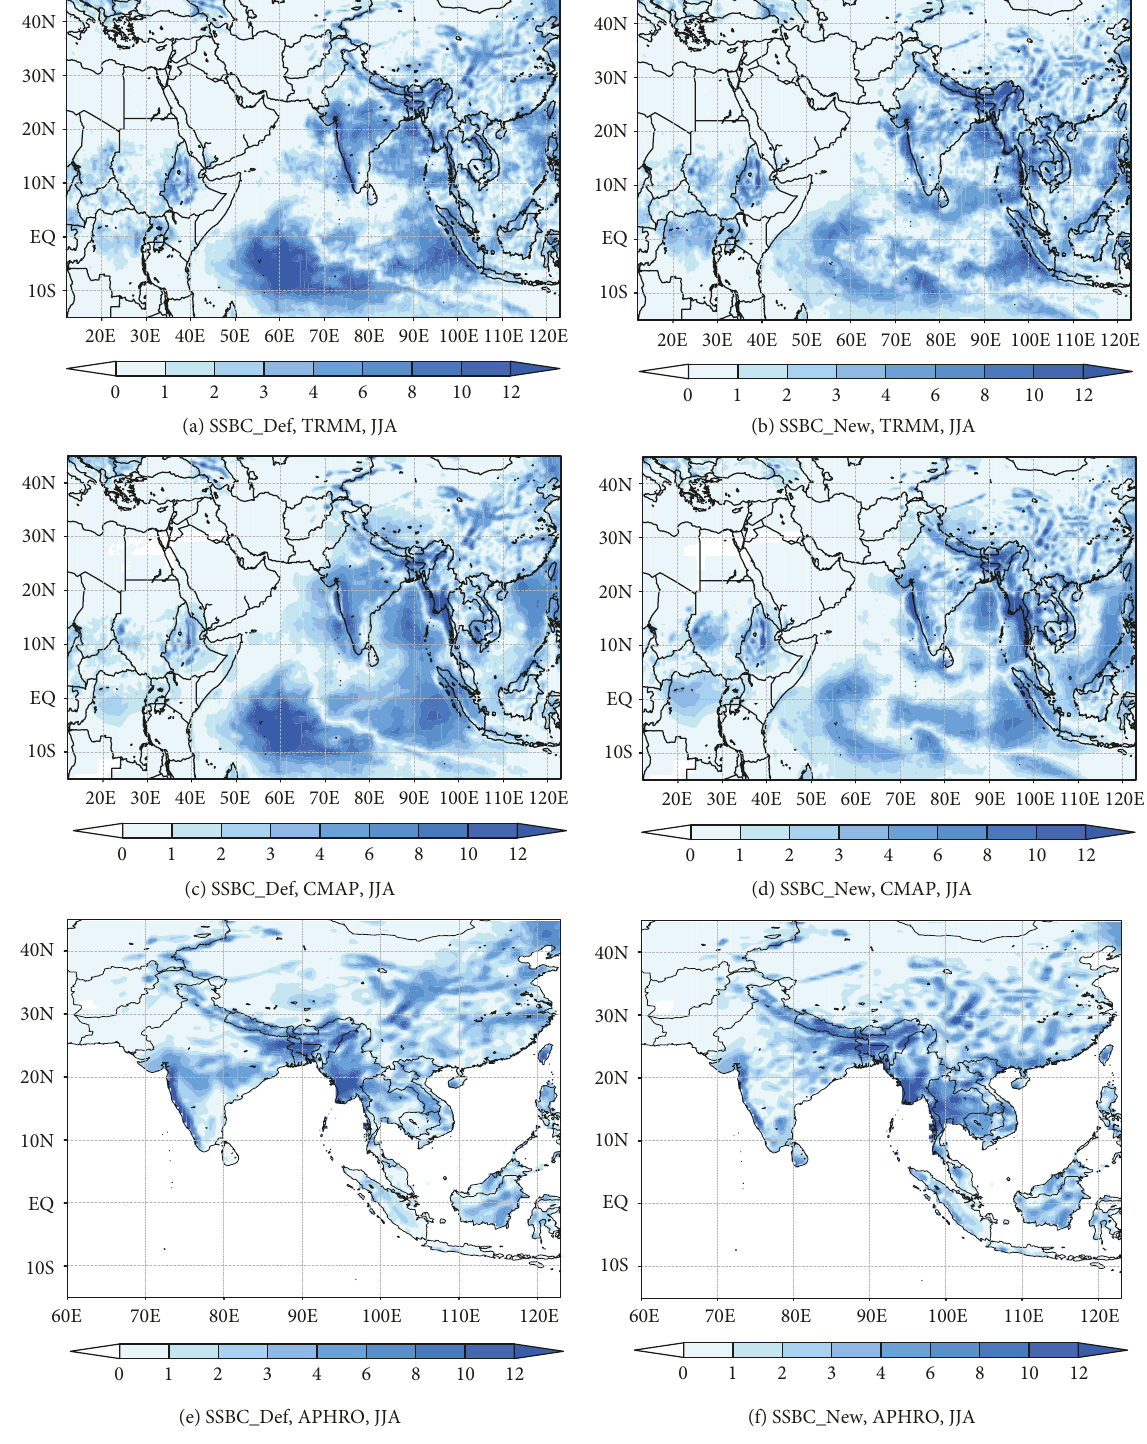
Figure 3: Root-mean-square error (RMSE) comparison of surface precipitation for June-July-August (JJA), 2005, of SSBC_Def (left column) and SSBC_New (right column) relative to TRMM (a and b), CMAP (c and d), and APHRODITE (e and f) surface precipitation (mmd −1